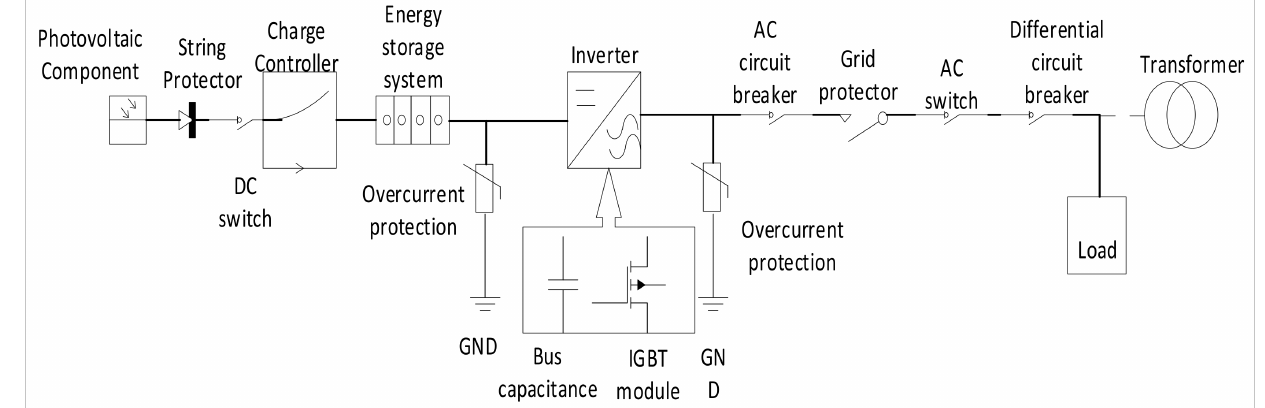
Figure 1. Typical electrical structure diagram of a grid-connected PV power plant.